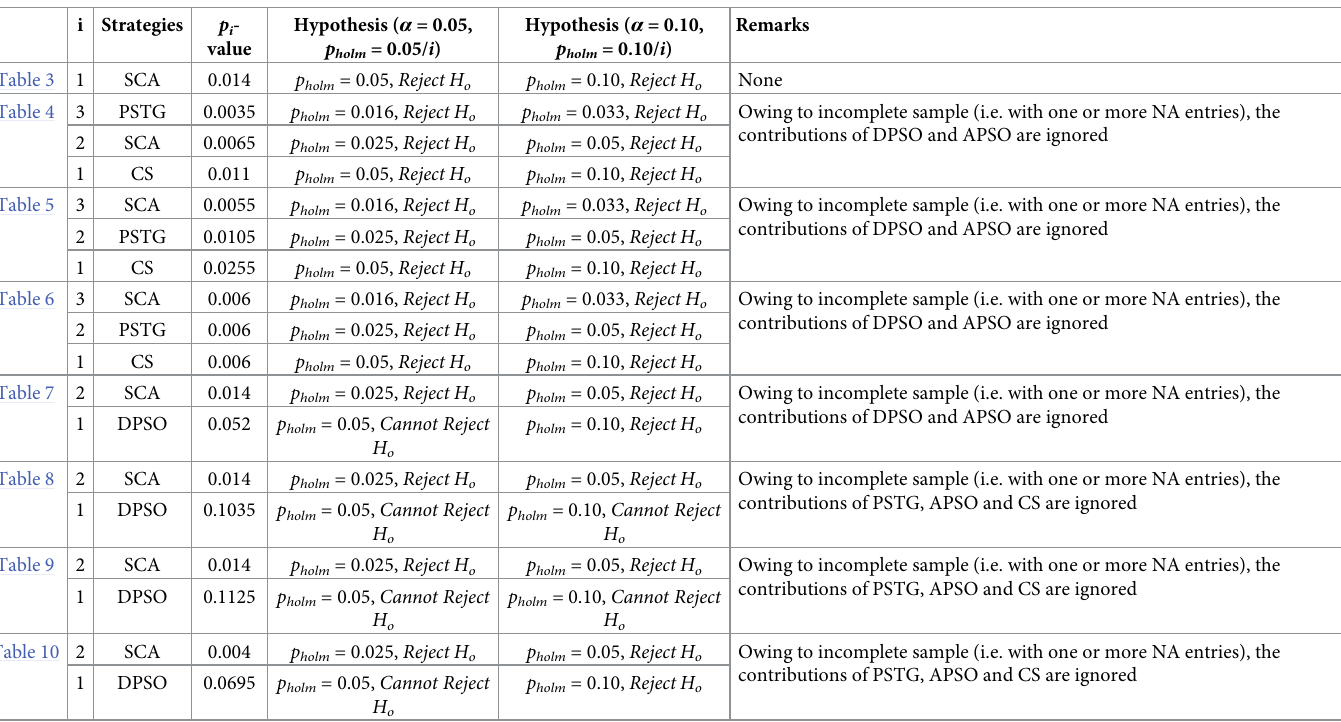
Table 11. Wilcoxon rank-sum tests for Tables 3 till 10 with QLSCA as control strategy. i